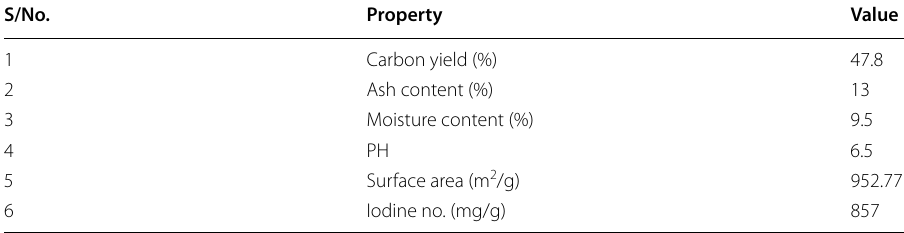
Table 2 Properties of the tamarind seed activated carbon granules